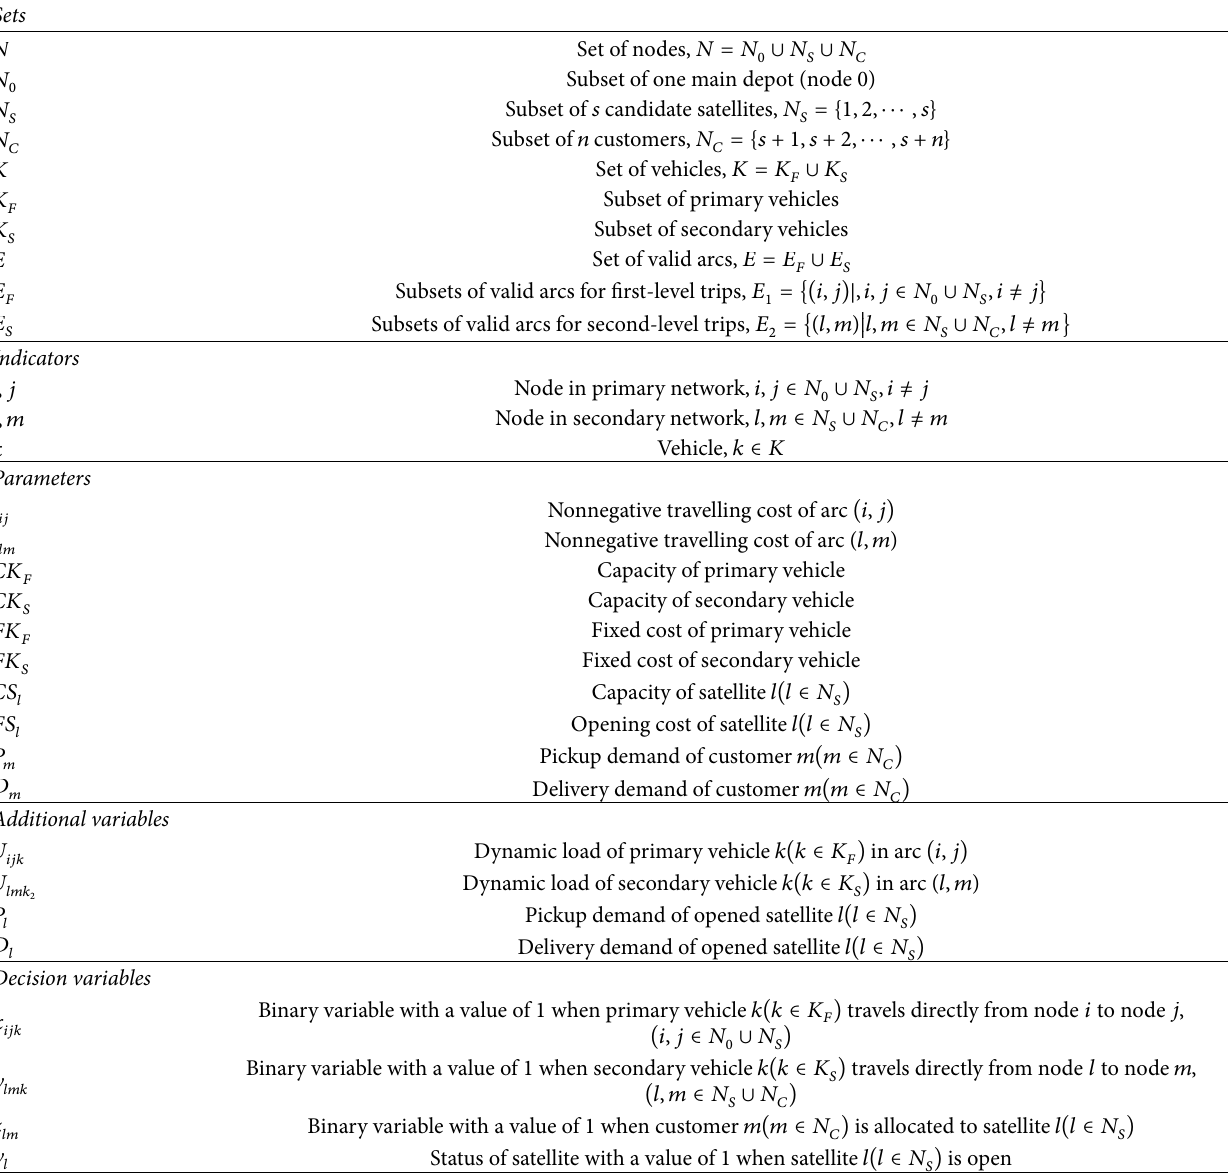
Table 2: Parameters and variables used in the mathematical